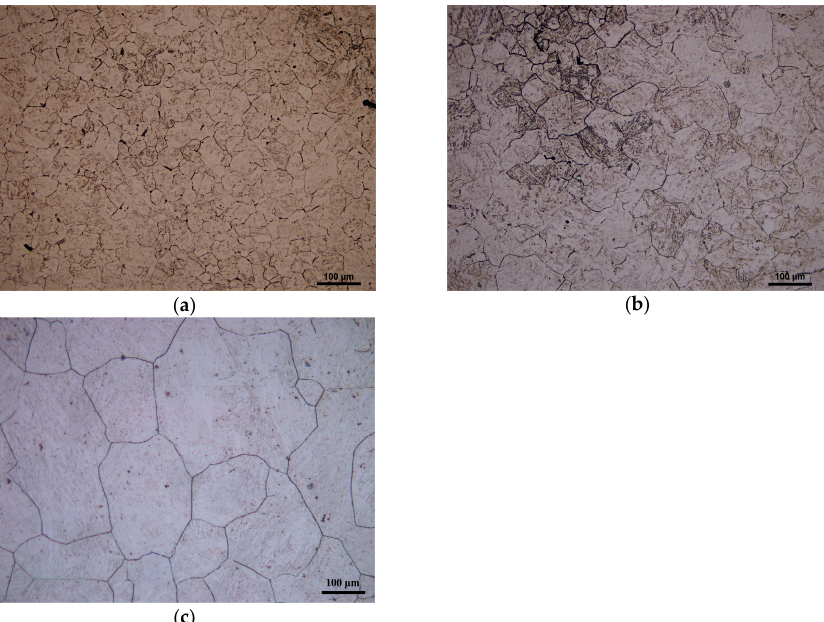
Figure 4. Microstructure of 20Mn5 steel compressed to a true strain of 0.7 under temperature of 1200 °C and strain rates of: ( a ) 1/s; ( b ) 0.1/s; ( c ) 0.01/s.